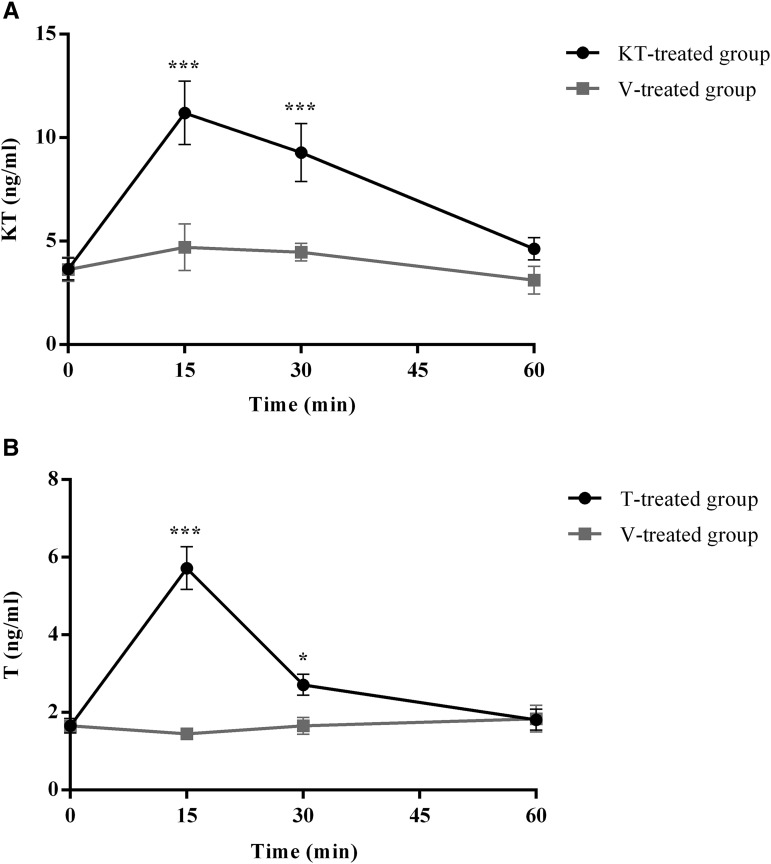
Temporal pattern of androgen circulating levels of fish injected with vehicle (V-treated group), 11-ketotestosterone (KT-treated group) or testosterone (T-treated group). Sample size for each point: 8-11 individuals. Values are mean ± standard error of the mean (SEM). A. 11-ketotestosterone (KT) levels of V and KT-treated groups; B. testosterone (T) levels of V and T-treated groups; * P < 0.05; *** P < 0.001.